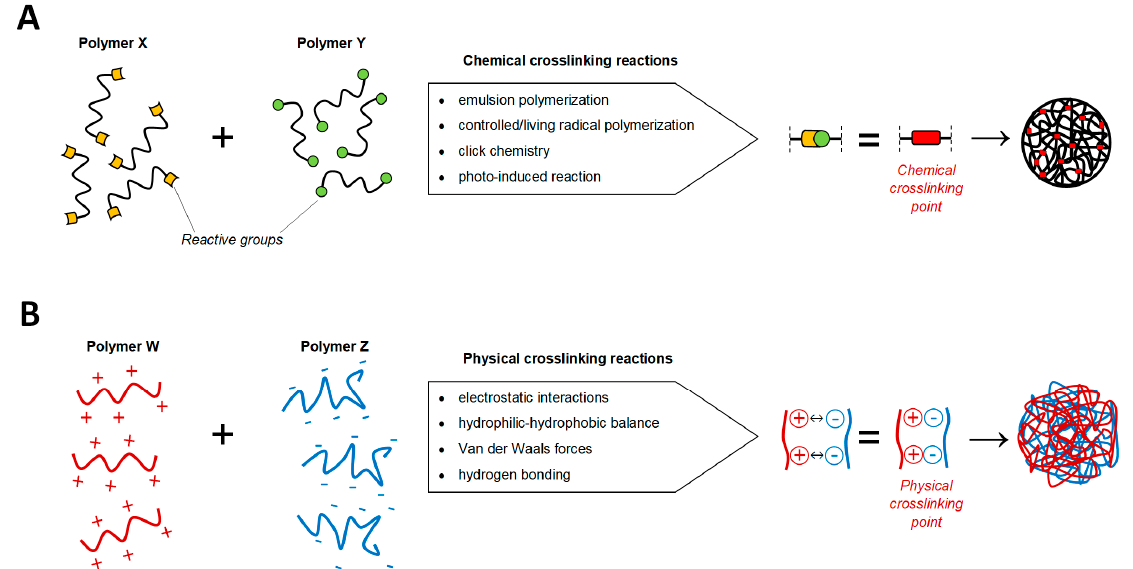
Figure 1. Summary of the chemical and physical crosslinking methods in nanogels (NG) design. ( A ) The formation of covalent bonds (crosslinking points, in red) between the reactive moieties (yellow and green) of polymers X and Y can be addressed through different chemical reactions exploiting the nature of the reacting groups. ( B ) The physical interactions between polymers W and Z enables the formation of a self-assembled nanoscaffold.